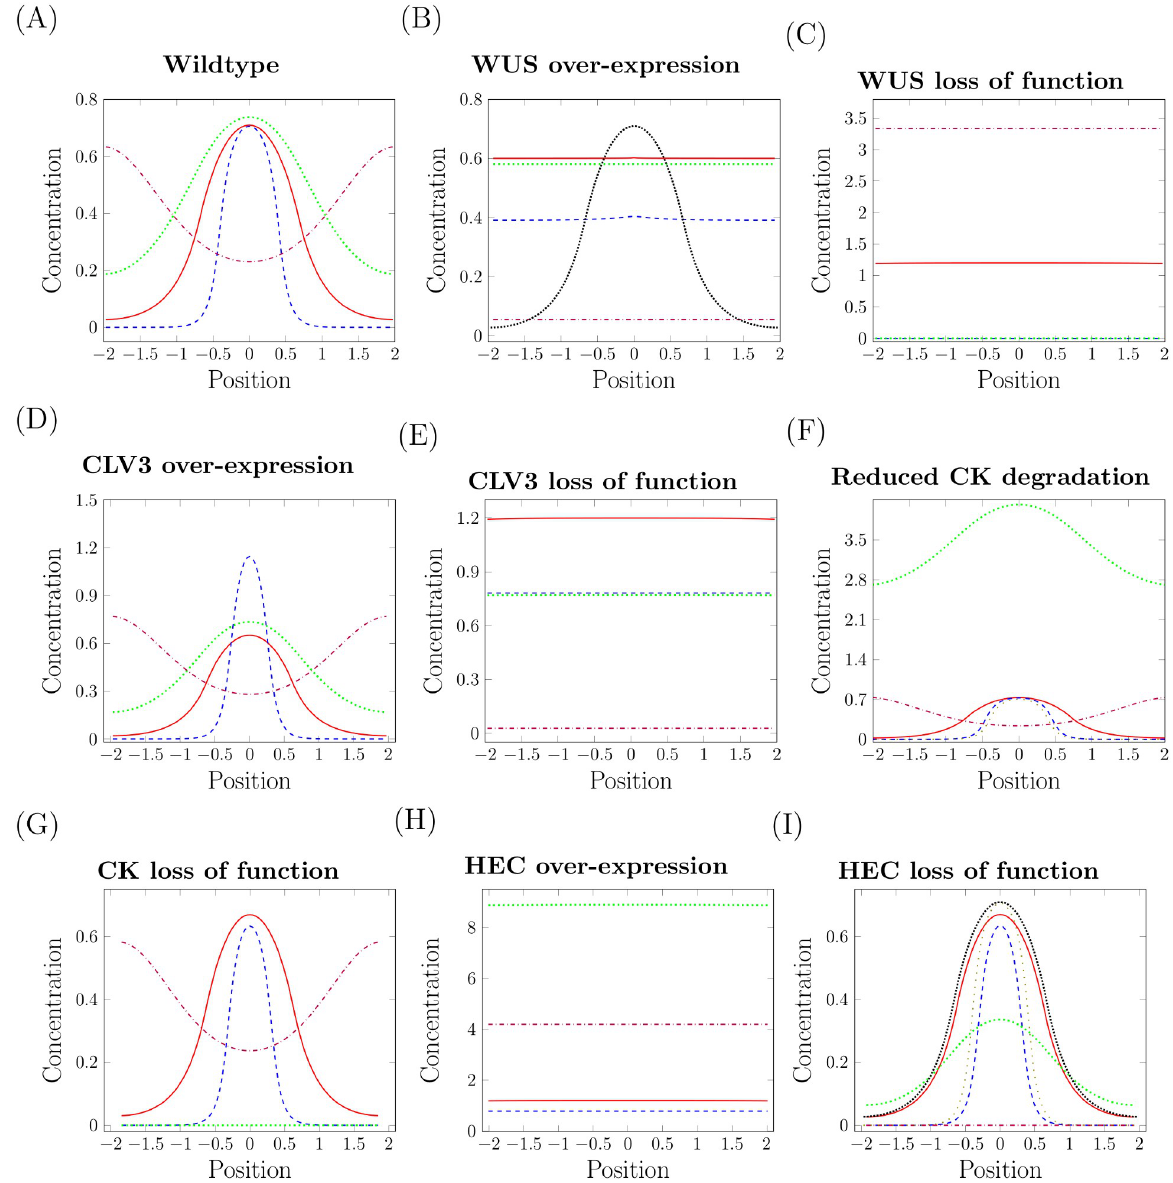
Fig 3. Signal concentrations in over-expression and loss-of-function experiments. Signal concentrations along the diameter of the meristem, position 0 corresponds to the center: WUS (solid red), CLV3 (dashed blue), CK (dotted green) and HEC (dashdotted purple). (A) Unperturbed steady-state of the wild-type meristem. (B) Ubiquitous over-expression of WUS: The system converges to a state with CLV3 expression in the whole meristem. The equilibrium concentration of WUS in the wild-type is shown for comparison (densely dotted black). (C) WUS loss of function: The system converges to a steady-state with negligible CLV3 concentrations, which corresponds to the experimentally observed loss of stem cells. Breakdown of the negative feedback between WUS and CLV3 leads to high concentrations of WUS molecules that are not functional. (D) CLV3 over-expression: The system converges to a state with higher CLV3 and slightly reduced WUS concentrations. (E) CLV3 loss of function: Due to the missing negative feedback the OC expands and the CZ spreads over the whole meristem. (F) Reduced degradation of CK: The system converges to a state with constant in space signal concentrations. For comparison the CLV3 profile of the wild-type steady-state is depicted (loosely dotted olive). (G) CK loss of function does not lead to significant changes in the simulations. (H) HEC over-expression in stem cells: The central zone expands until it reaches the boundary of the meristem. (I) HEC loss of function (so called HEC triple mutant): The system converges to a state with lower WUS and CLV3 concentrations and a smaller meristem. HEC concentration (dashdotted purple) is equal to zero. For comparison, the CLV3 (loosely dotted olive) and WUS (densely dotted black) profiles of the wild-type steady-state are depicted.